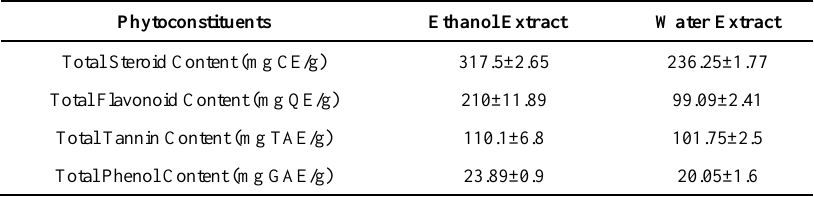
Table 2. Estimation of phytoconstituents from stem barks of Phyllanthus Albizzioides